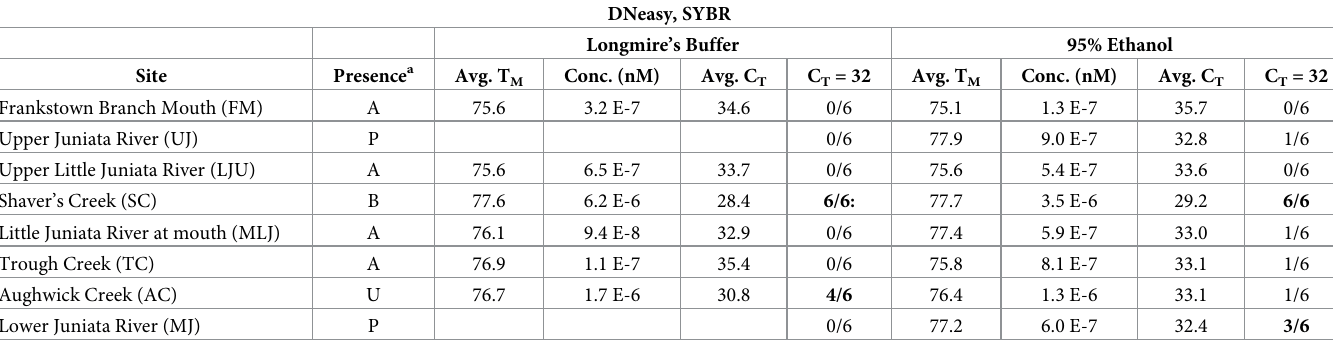
Table 4. A Qiagen’s DNEasy extraction kit with a SYBR Green qPCR assay.